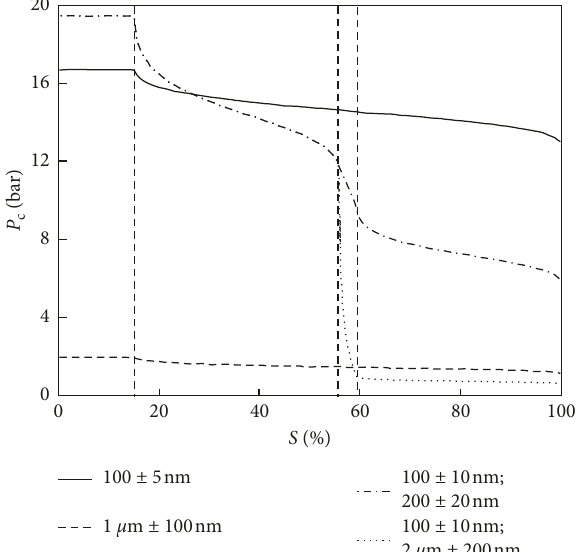
Figure 4: Capillary pressure for four cases of mono- and bimodal